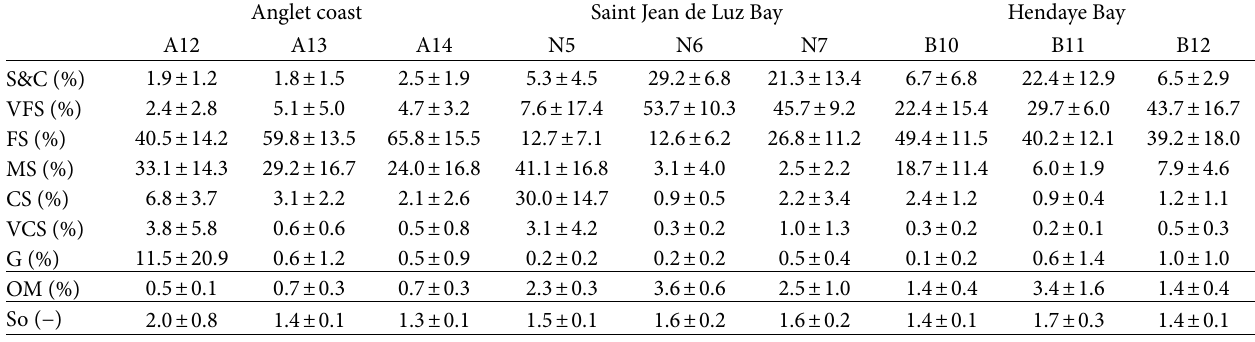
Table 3: Grain size (%), organic matter content (%) and the Sorting Index for each station during the different campaigns along the Anglet coast and within the Saint Jean de Luz and the Hendaye Bays. The standard deviation is calculated for each sedimentary parameter in each station during the eight sampling campaigns.